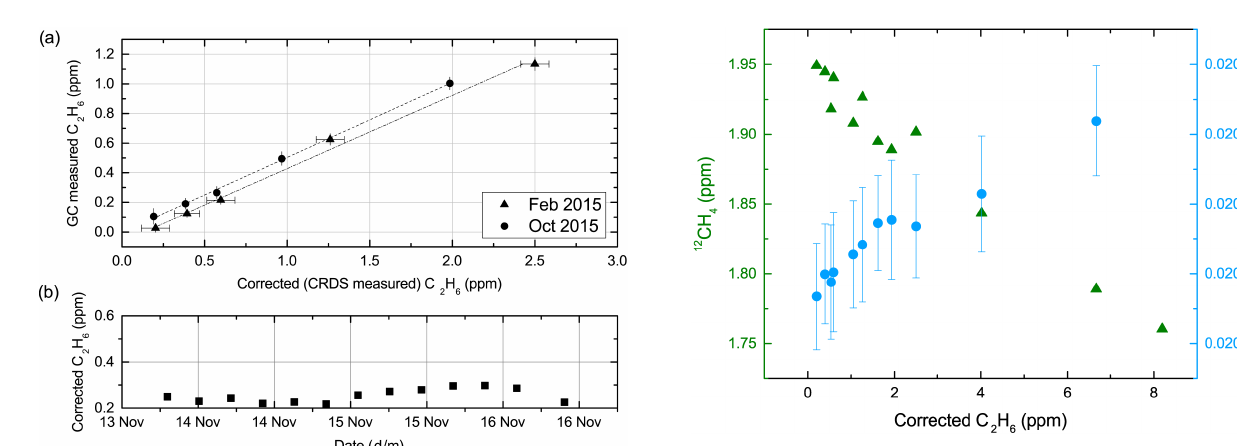
Figure 7. (a) Ethane calibration calculated from measurements of flask samples by both the GC and CRDS. The x -axis is the cor- rected C 2 H 6 (C 2 H 6COR ) using the corrections described previ- ously. The y -axis is the C 2 H 6 as measured by a manual GC. The error bars indicate the standard deviation of each flask measure- ment, for certain flasks error bars are smaller than their respective markers. (b) 30min target measurements over a period of 4 days, from 13 to 16 November 2015. The standard error of each target is smaller than the plotted marker. The baseline C 2 H 6 is seen to drift with time.